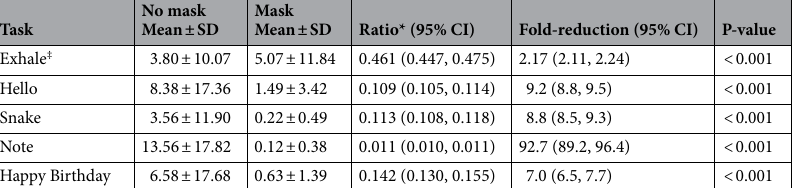
Table 1. Comparison of time averaged droplet number with and without a face mask. *Odds ratio expressed as number of droplets using mask relative to no mask. ‡ In a small number of participants, significant air egress through the mask led to a higher mean time averaged droplet number with a mask than without. Overall, TADN fell by more than 50% when wearing a